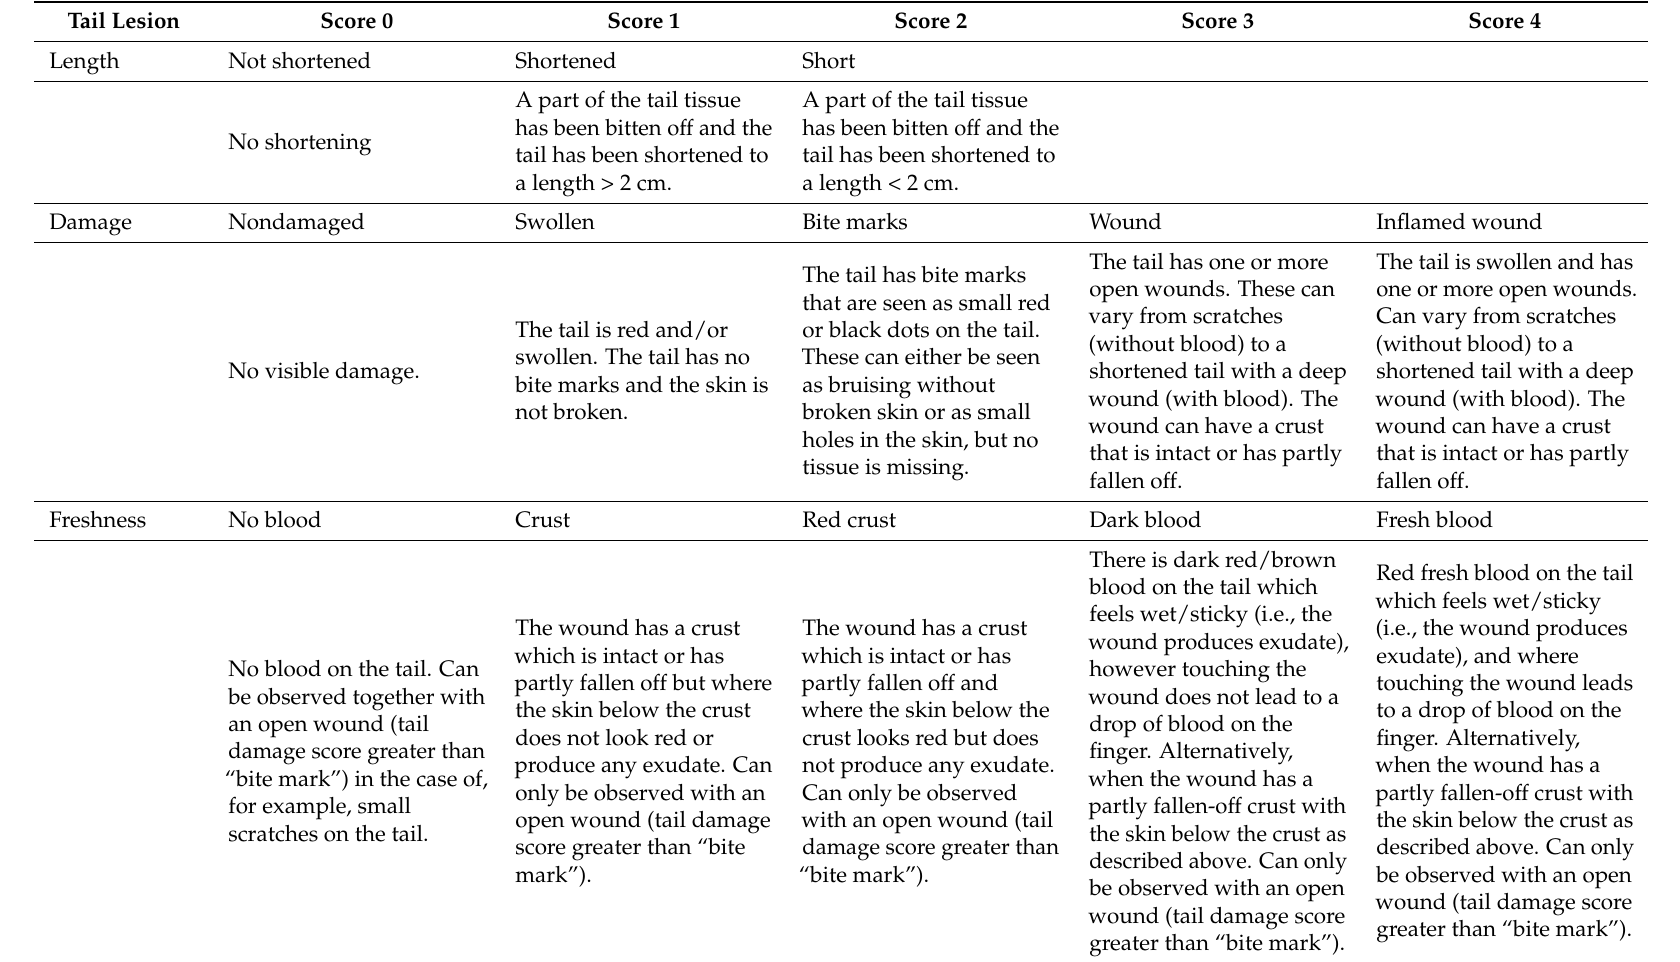
Table 2. Tail lesion scoring of tail length, tail damage and wound freshness, adapted from Zonderland et al.